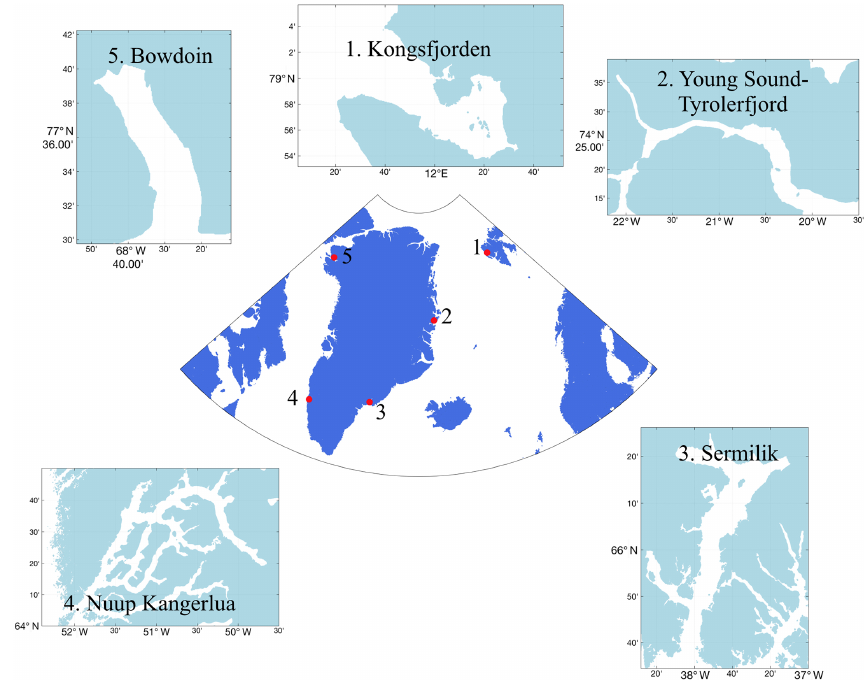
Figure 1. Locations of five key Arctic field sites, where extensive work bridging the glacier and marine domains has been conducted, discussed herein in order to advance understanding of glacier–ocean interactions. 1: Kongsfjorden (Svalbard); 2: Young Sound (E Greenland); 3: Sermilik (SE Greenland); 4: Nuup Kangerlua/Godthåbsfjord (SW Greenland); 5: Bowdoin Fjord/Kangerluarsuup Sermia (NW